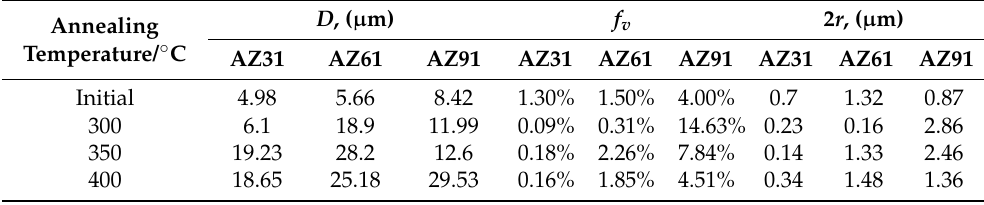
Figure 15. The relationship between the average grain size ( D ) and the average size (2 r ) and volume fraction ( f v ) of second phase particles. In which, the average size of the second phase particles at the grain boundaries only is counted. Table 3. The values of the average grain size ( D ), volume fraction ( f v ), and average size (2 r ) of the second phase particles for Mg – xAl – 1Zn (x = 3, 6, 9) alloys at different annealing conditions. In which, only the average size of the second phase particles at the grain boundaries is counted.